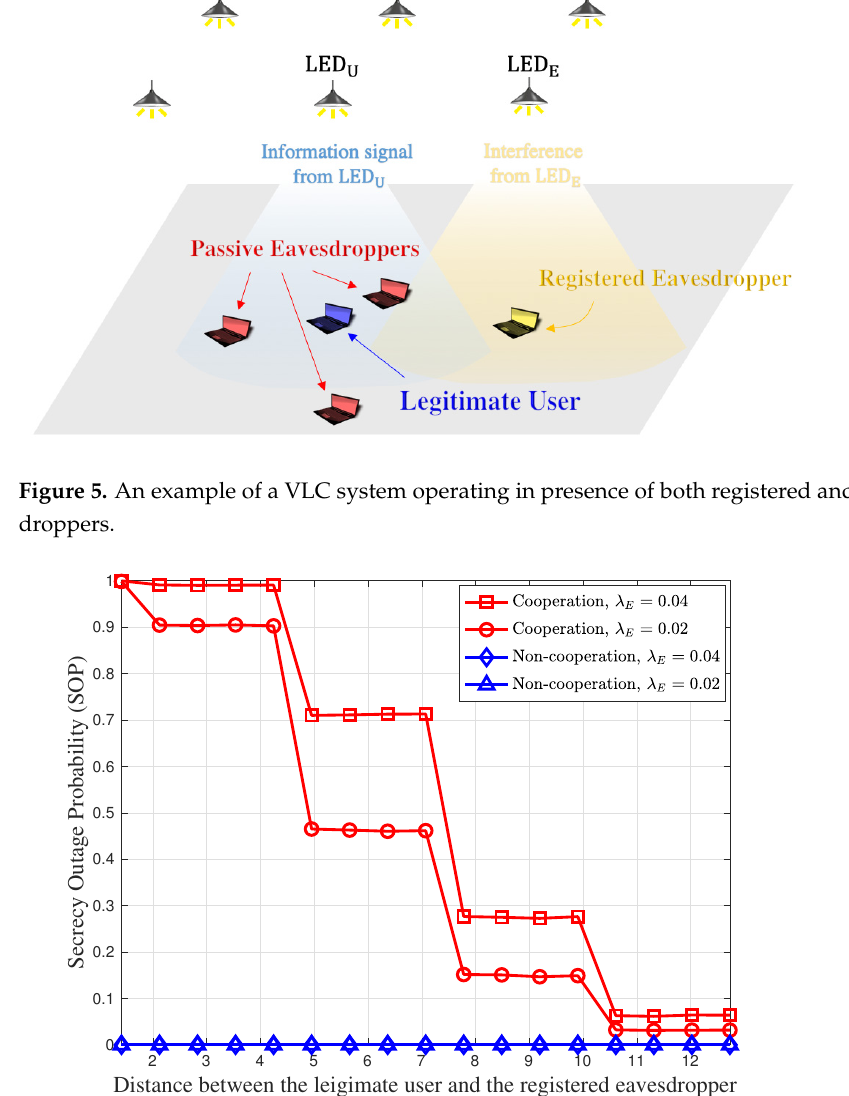
Figure 6. SOP for different densities of passive eavesdroppers ( λ E ) plotted as a function of distance between legitimate user and registered eavesdropper when registered and passive eavesdroppers cooperate. N T = 10 × 10 LED transmitters are assumed to be uniformly distributed on a square lattice in a room of dimension 20 × 20 m 2